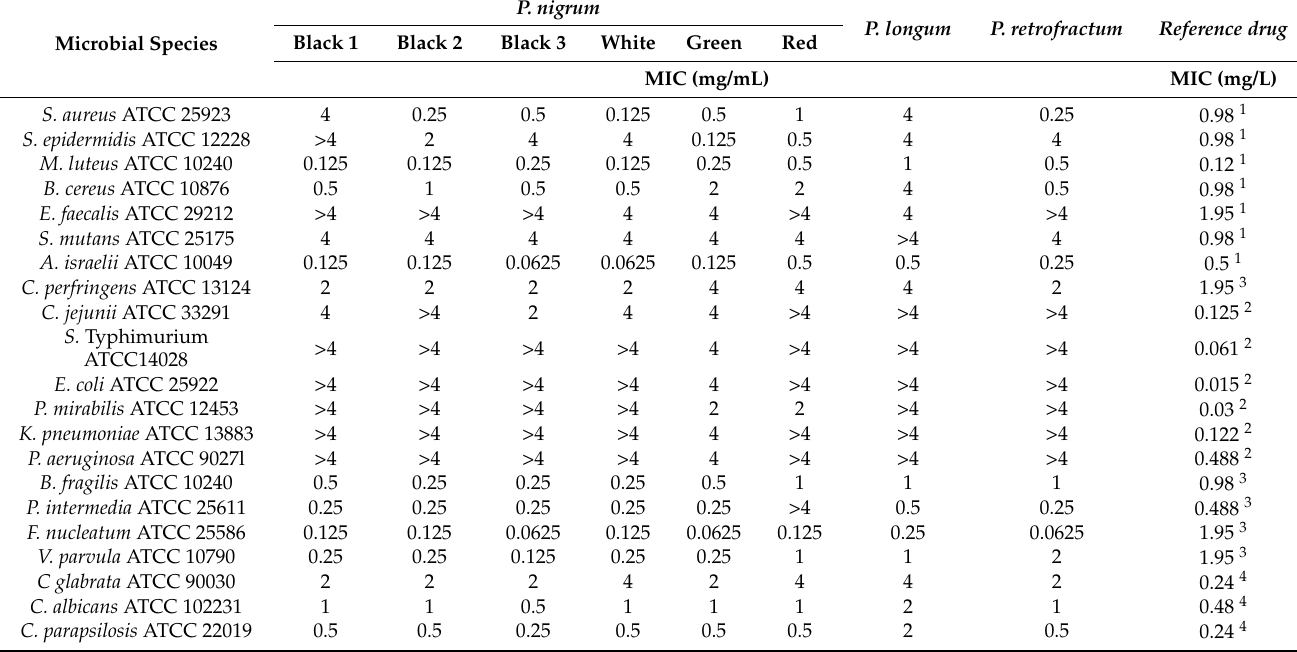
Table 4. Antimicrobial activity of the methanolic fruit extracts obtained from different spices of genus Piper . P. Microbial Species